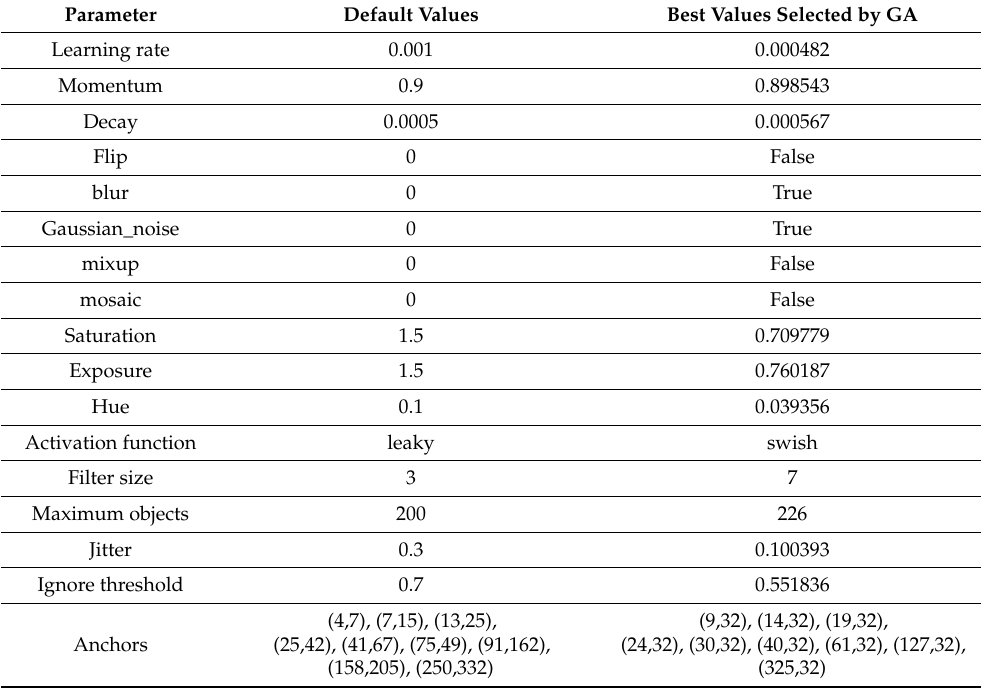
Table 6. Hyper-parameters of YOLO